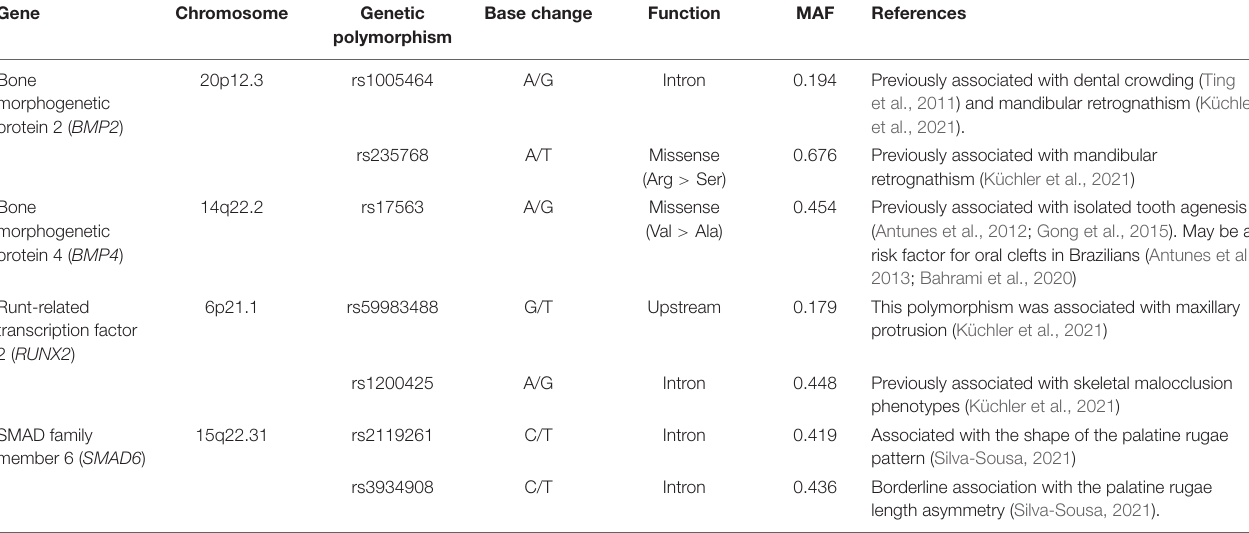
TABLE 1 | Characteristics of the selected genetic polymorphisms and previously reported associations with oral